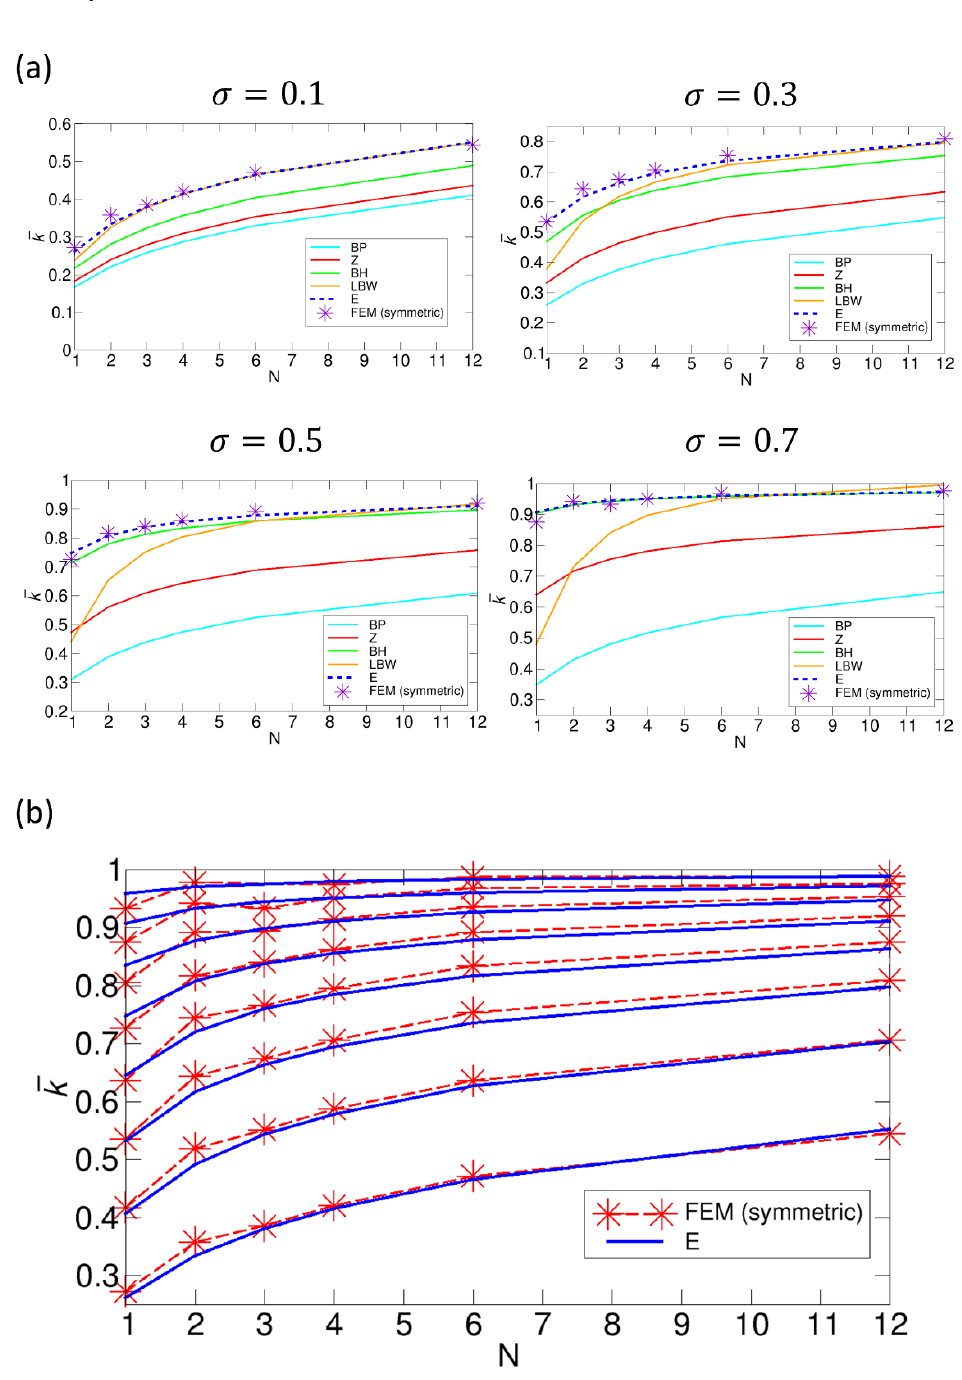
Figure 9. ( a ) Comparison of the normalized rate constants 𝑘̅ as functions of the number of patches 𝑁 , obtained from various methods under fixed 𝜎 values of 0.1, 0.3, 0.5, and 0.7. The normalized rate constants for the Berg-Purcell (BP), the Zwanzig (Z), the boundary homogenization (BH), the Lindsay-Bernoff-Ward (LBW), and our (E) theory are calculated from Equations (1), (2), (3), (4), and (6), respectively. ( b ) Comparison of the results from our theory (E) with the FEM results for symmetric patch distributions (FEM) from 𝜎 = 0.1 (bottom) to 𝜎 = 0.8 (top) with an increment of 0.1.